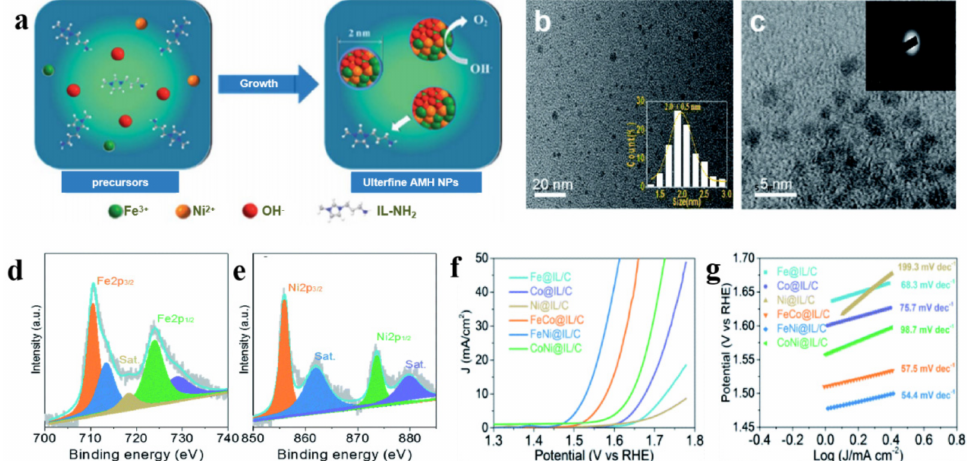
Figure 1. Strategy for the synthesis of amorphous NiFe hydroxide ( a ), HRTEM image ( b ), HAADF- STEM image (inset: the corresponding SAED pattern) ( c ) and high-resolution XPS spectra of Fe 2 p ( d ), Ni 2 p ( e ) of amorphous NiFe hydroxide, polarization curves ( f ) as well as Tafel slopes ( g ) of amorphous NiFe hydroxide and the comparative electrocatalysts for OER in alkaline solution (Reprinted with permission from Ref. [34], 2020, Royal Society of